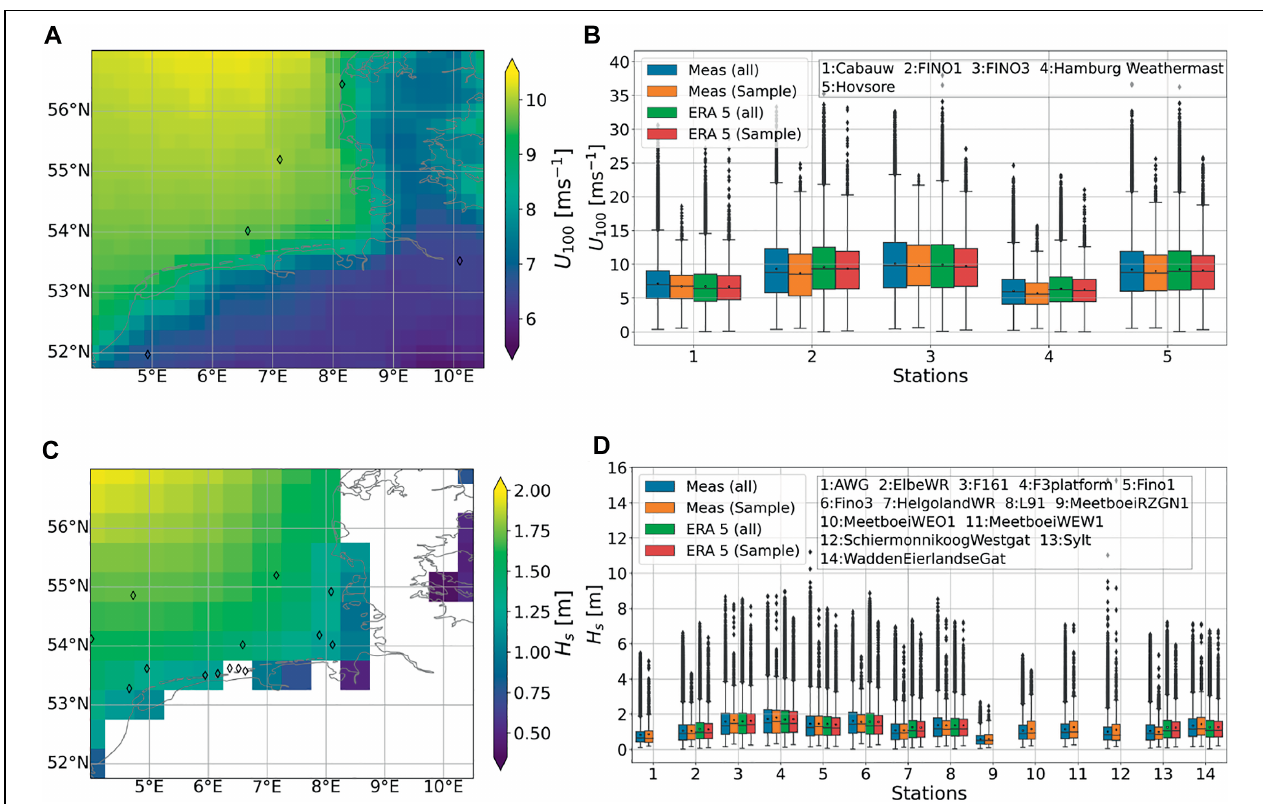
FIGURE 5 | ERA5 30-years average (A) wind speed at 100 m height ( U 100 ) and (C) significant wave height ( H s ) with coloured diamonds showing the representativity of the 180 selected days. (B) U 100 and (D) H s boxplots of measurement climate (blue) and ERA5 climate (green) per station as well the respective boxplot from the 180 sample days (orange and red,